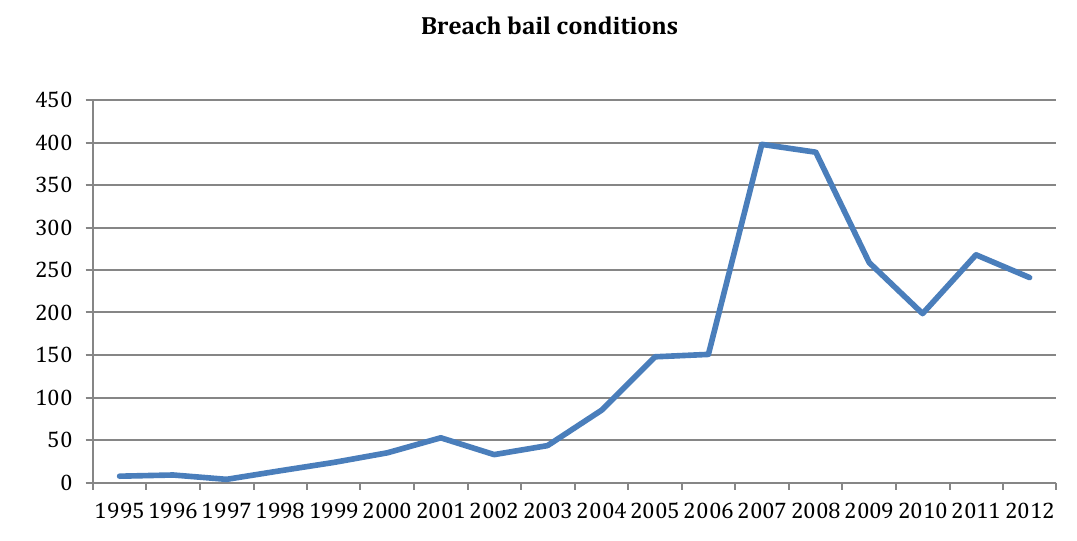
Figure 2: Incidents of breach of bail conditions in Glebe between 1995 and 2012 Source: BOCSAR Data File – Reference: